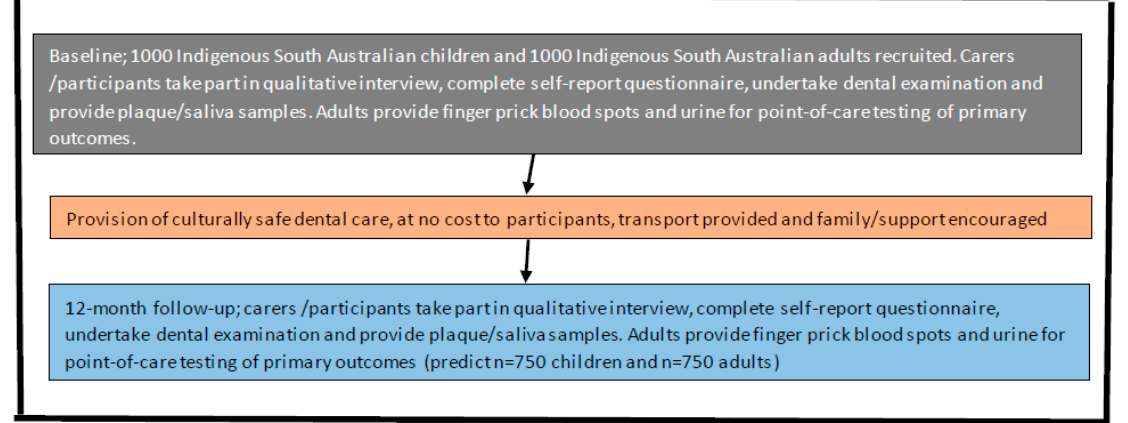
Figure 2. Study plan schema.